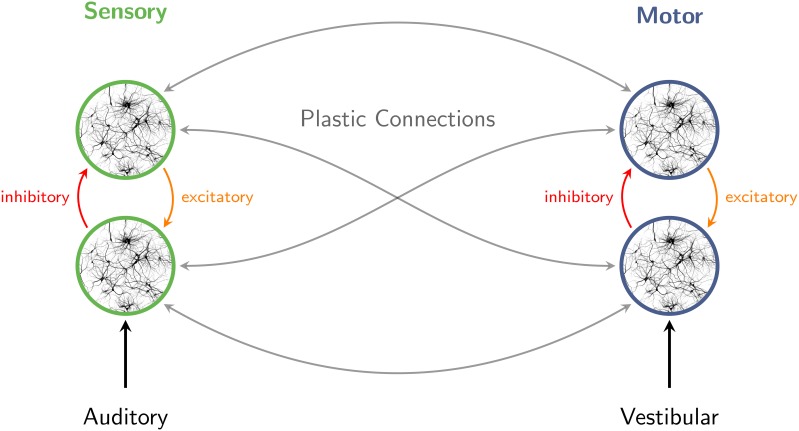
Interaction of excitatory and inhibitory neuronal populations gives rise to population rhythms in sensory and motor networks. When sensory stimuli are presented in a periodic pattern, auditory cortical oscillations entrain to the structure of the stimulus stream. The perception of pulse and meter in music also involves broadly distributed motor systems. Auditory-motor coupling is reciprocal, as vestibular stimulation can influence auditory rhythm perception. Connections within and between sensory and motor systems are assumed to be plastic.